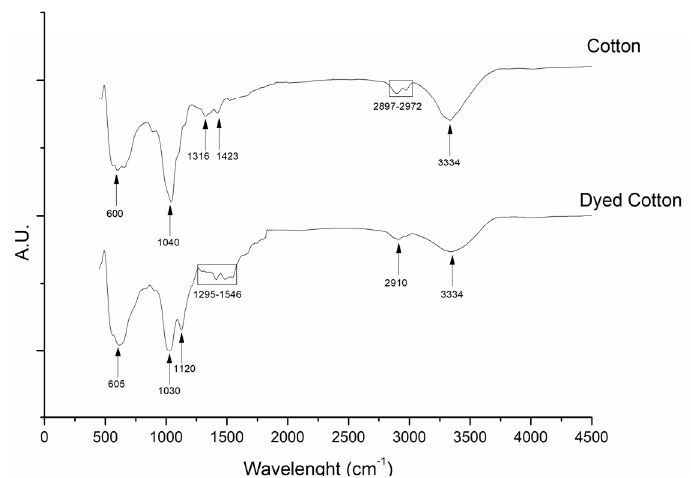
Figure 1. FTIR characterization of cotton dyed with nanoencapsulated navy blue